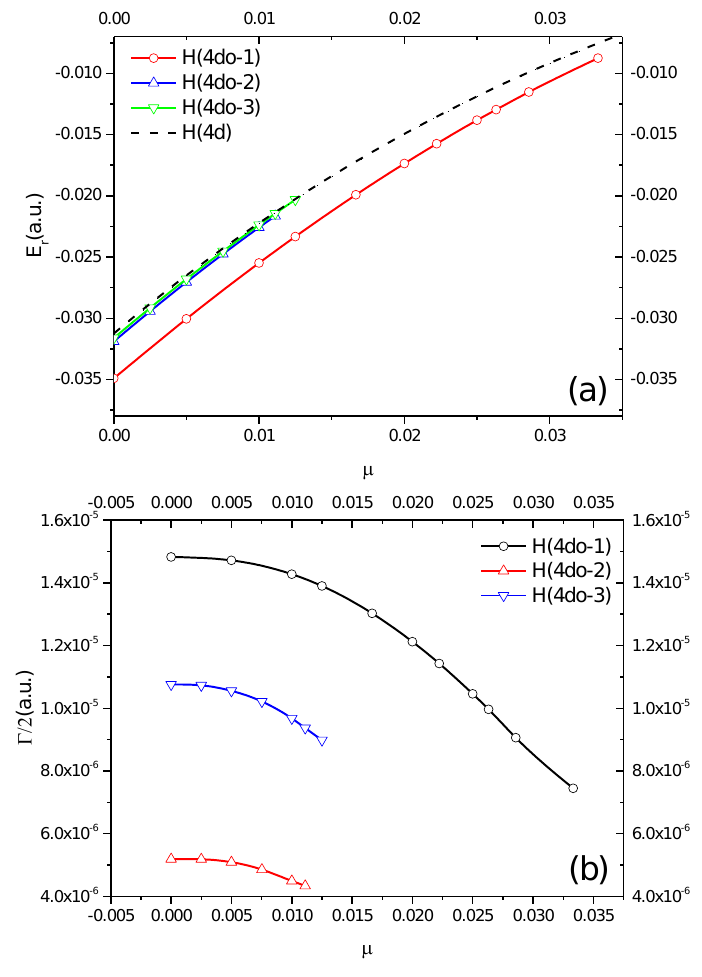
Figure 9. D -wave states with unnatural parity: ( a ) resonance energy and ( b ) half-width for the H(4d°- k ) states, with k = 1, 2, 3 as a function of μ = 1/ D .